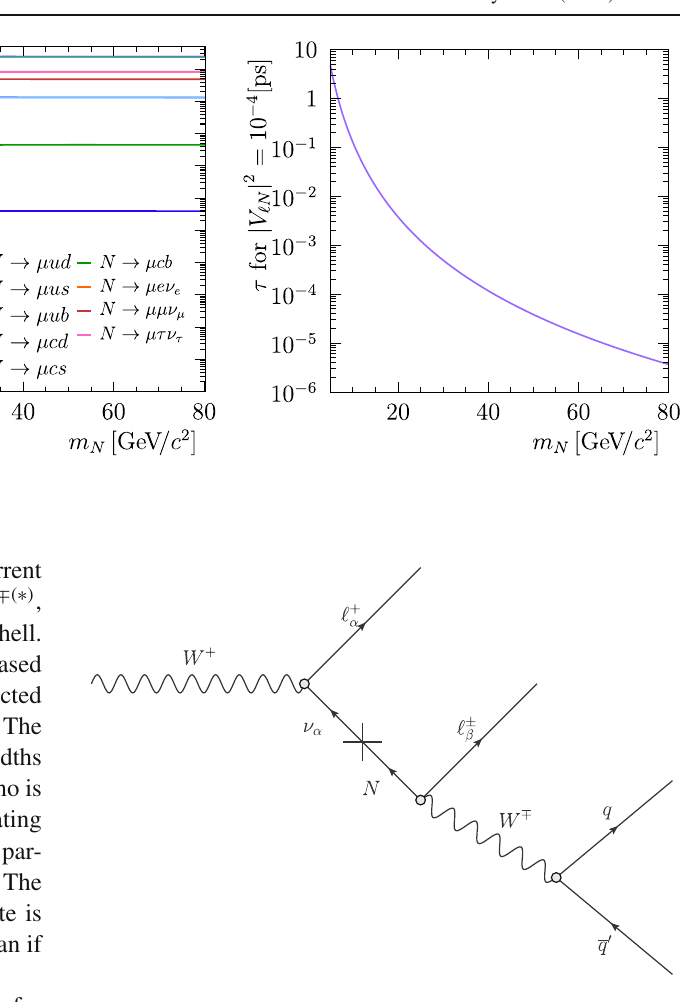
Fig. 2 Feynman diagram for the production of a heavy neutrino via mixing with a neutrino from the decay of a W boson and semileptonic decayoftheheavy neutrino intoaleptonandtwoquarks. The subscripts α and β indicate the lepton flavour. In this analysis α and β are both